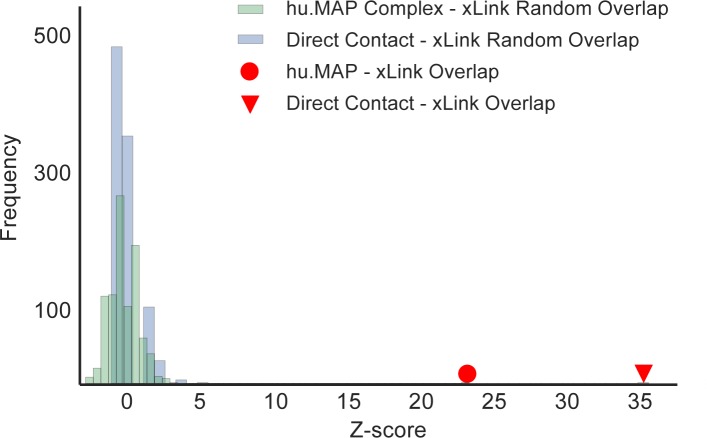
Direct contact predictions have highly enriched overlap with HeLa lysate crosslinking interactions.We report the enriched overlap of direct contact predictions and crosslinking interactions (z-score = 36, red triangle) relative to a distribution of random pairs of proteins in the crosslinking dataset (blue). Since we restrict our direct contact predictions to co-complex interactions within hu.MAP complexes, we additionally compare to the enriched overlap of co-complex edges and crosslinking interactions (z-score ~24, red circle). This shows direct contact predictions have a highly enriched overlap with crosslinking interactions above expected by co-complex edges alone.